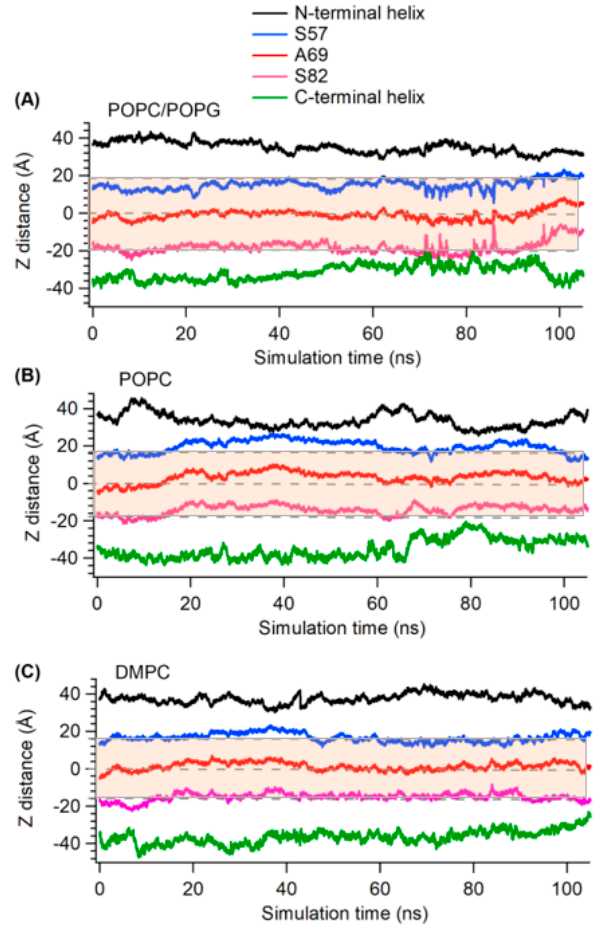
Figure 6. The plot of z -axis distance (Z-distance) as a function of simulation time for KCNE3 incorporated into POPC/POPG ( A ), POPC ( B ), and DMPC ( C ) lipid bilayers. Shaded regions represent the average width of the corresponding lipid bilayers calculated from Figure